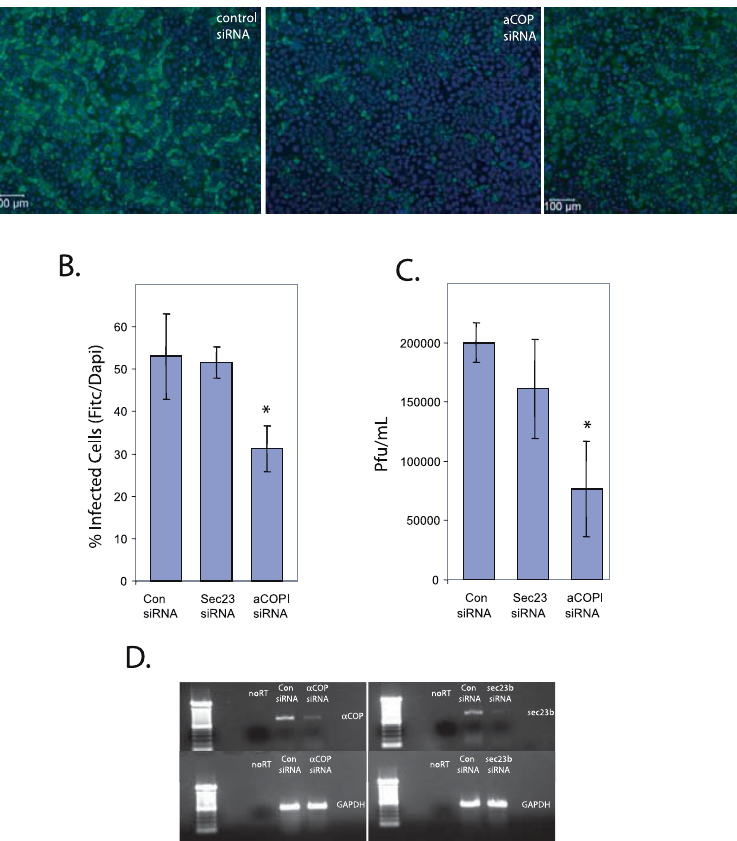
Figure 6. Attenuation of COPI but Not COPII Protects Human Cells from Poliovirus Infection (A) Poliovirus infection of Caco-2 cells pretransfected with siRNAs against alphaCOP results in inhibition of viral replication but not control siRNA or siRNA against sec23B as measured by immunofluorescence analysis of infected cells (nuclei [blue] ¼ DAPI, infected cells [green] ¼ FITC-conjugated mouse anti-enterovirus VP1). (B) Percent infection (FITC-positive cells/DAPI * 100) is shown for two independent experiments performed in triplicate where error bars represent one standard deviation. * p , 0.05. (C) Plaque-forming units/mL (pfu/mL) are shown for the experiments performed in (B). * p , 0.05. (D) RT-PCR on Caco-2 cells treated with siRNA against alphaCOP or sec23B demonstrates that treatment with either siRNA leads to a significant depletion of the cellular mRNA and amplification of GAPDH was used as loading control. DOI: